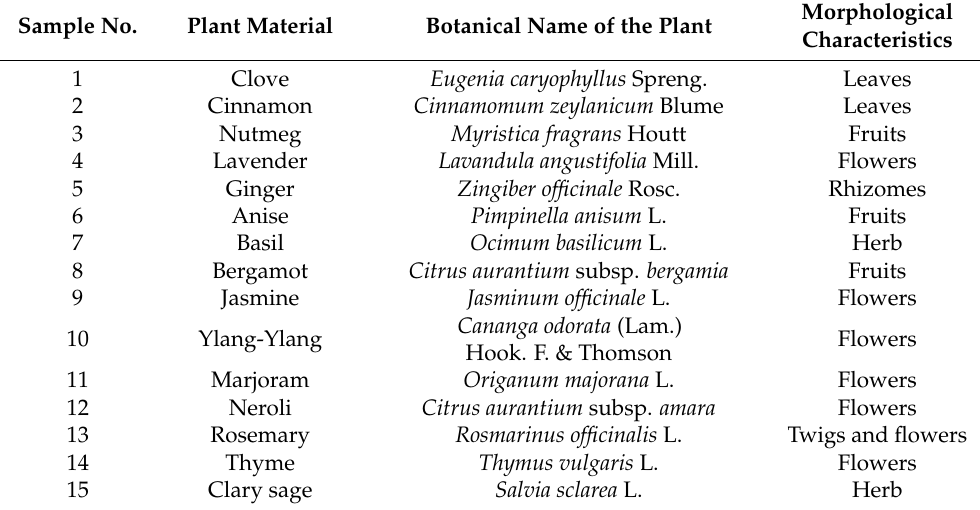
Table 1. Essential oils under